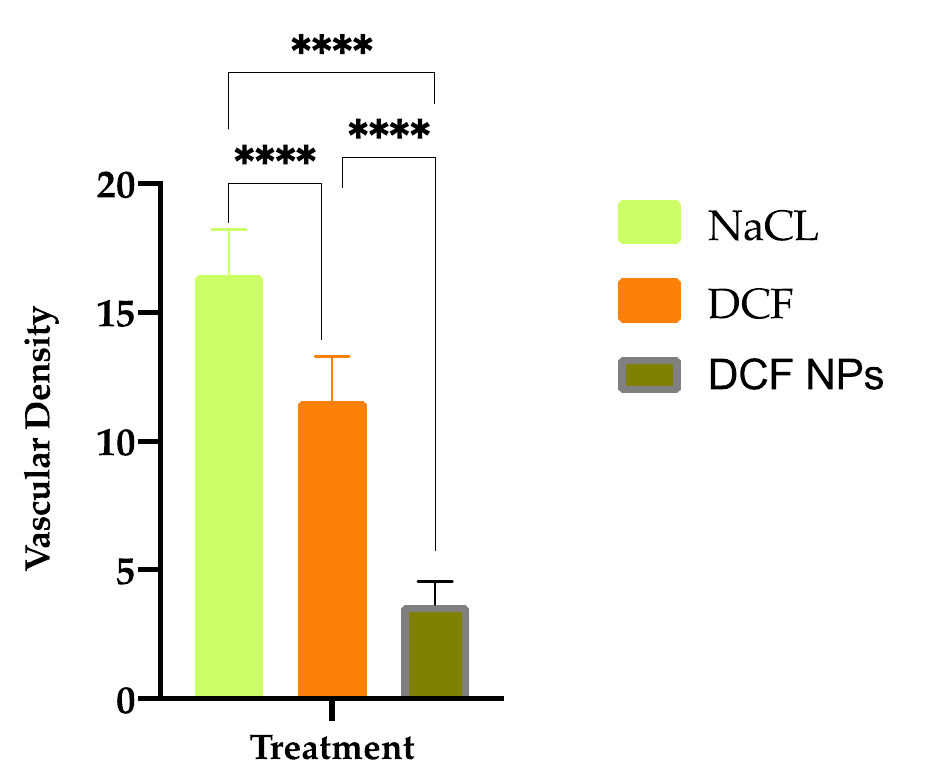
Figure 6. Vascular density results of the membranes after 48 h of product application (**** p < 0.0001). 3.8. Cytotoxicity of Fabricated Formulation towards Selected Cancer Cell Lines